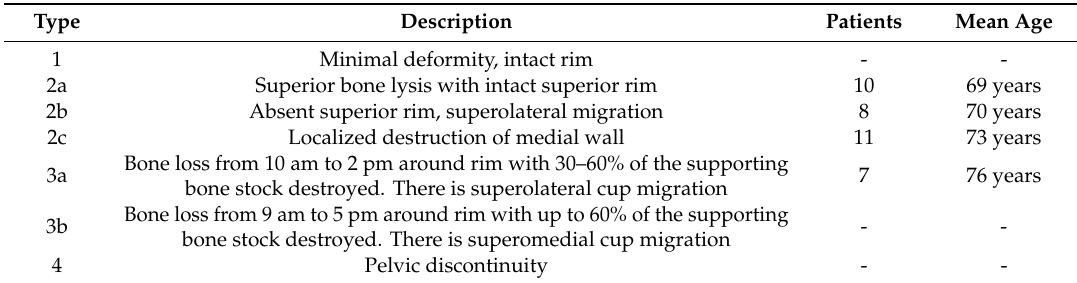
Table 1. Paprosky’s classification of acetabular bone